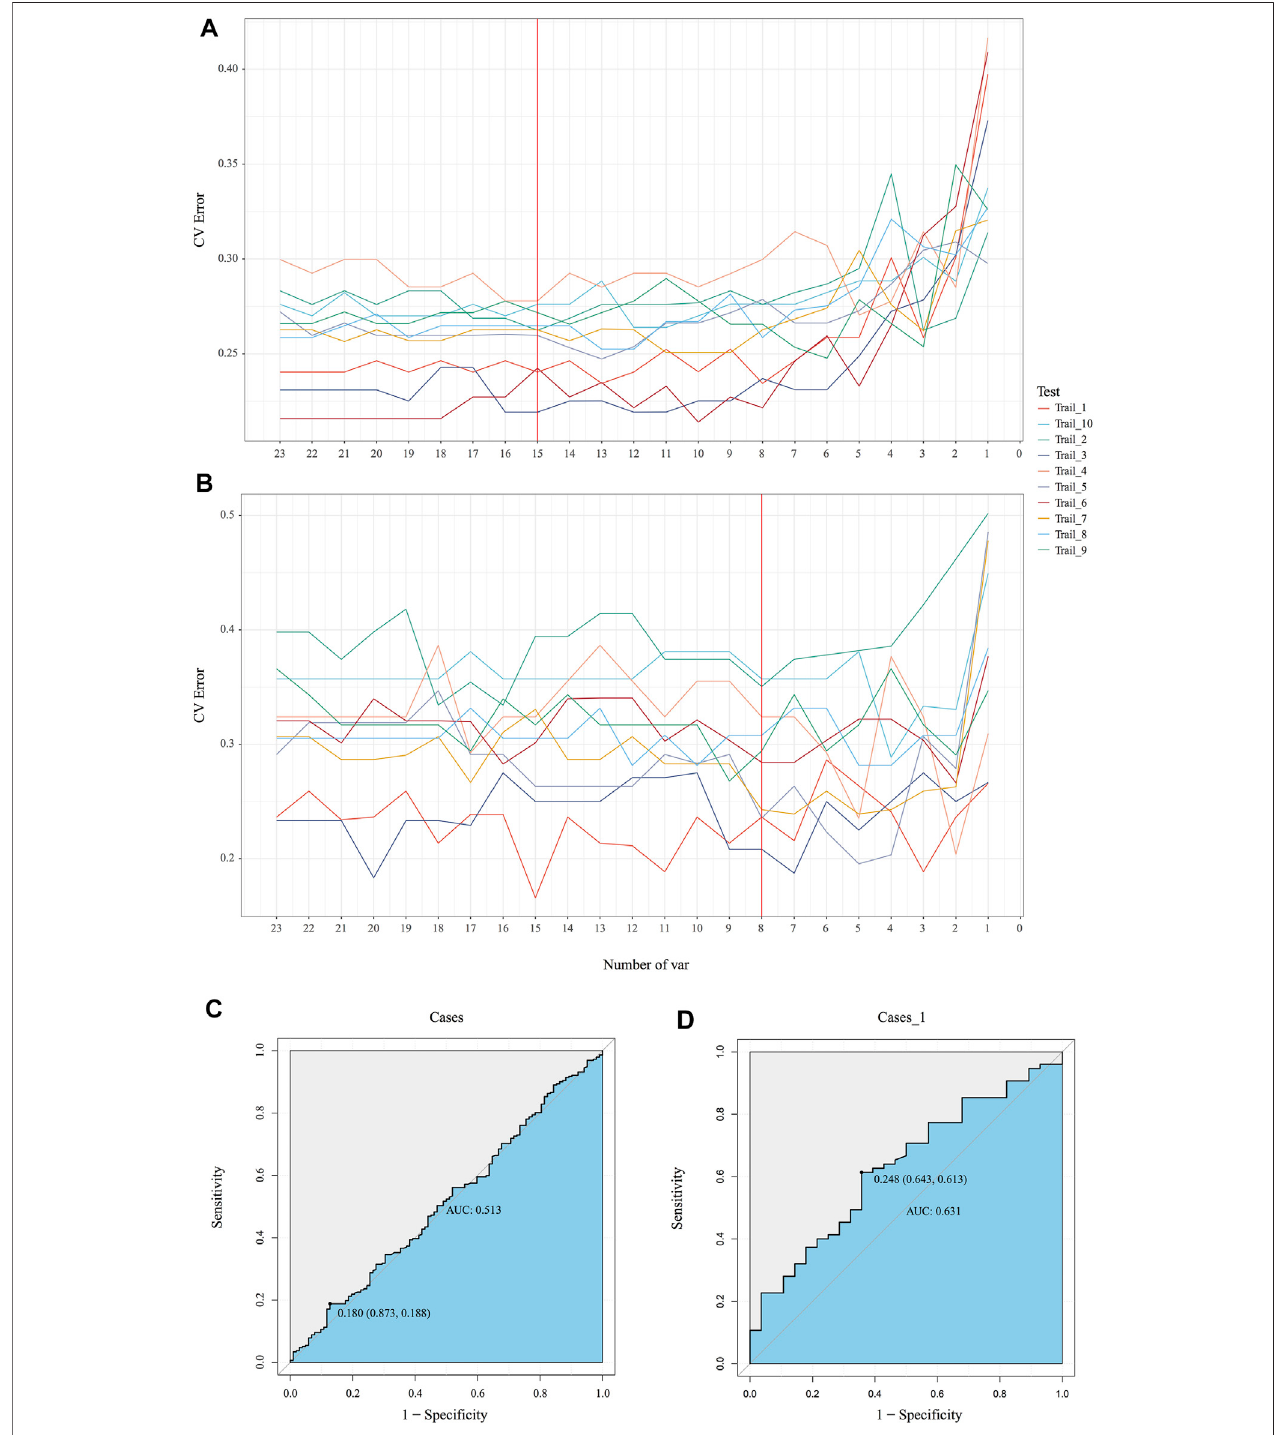
FIGURE 4 | Identi fi cation of the signature gut microbiota by random forest. (A, B) To explore the signature biomarkers, a fi vefold cross validation together with random forest was performed. (C, D) Based on key bacterial taxa generated by EMP package, receiver operating characteristic curves (ROC) were performed to test prediction